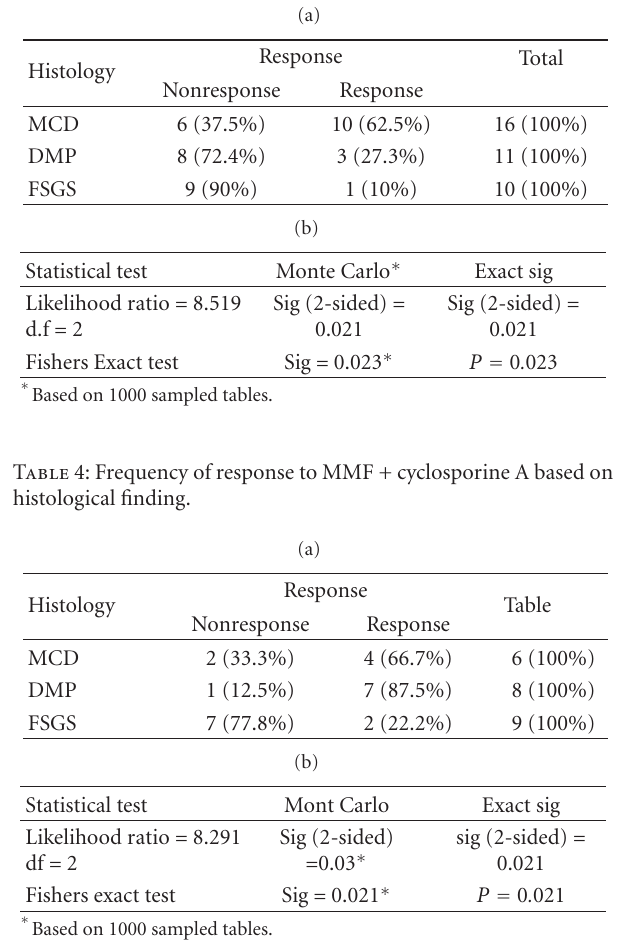
Table 3: Frequency of response to prednisolone + cyclosporine A based on histological finding.